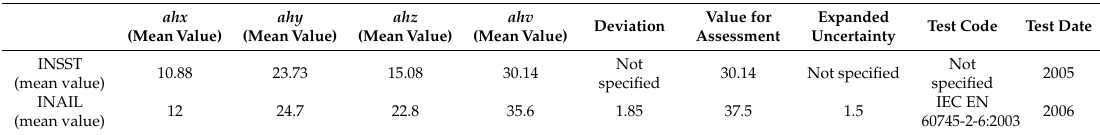
Table 2. Comparison between INSST and INAIL data bases for a specific tool and application (from the works in